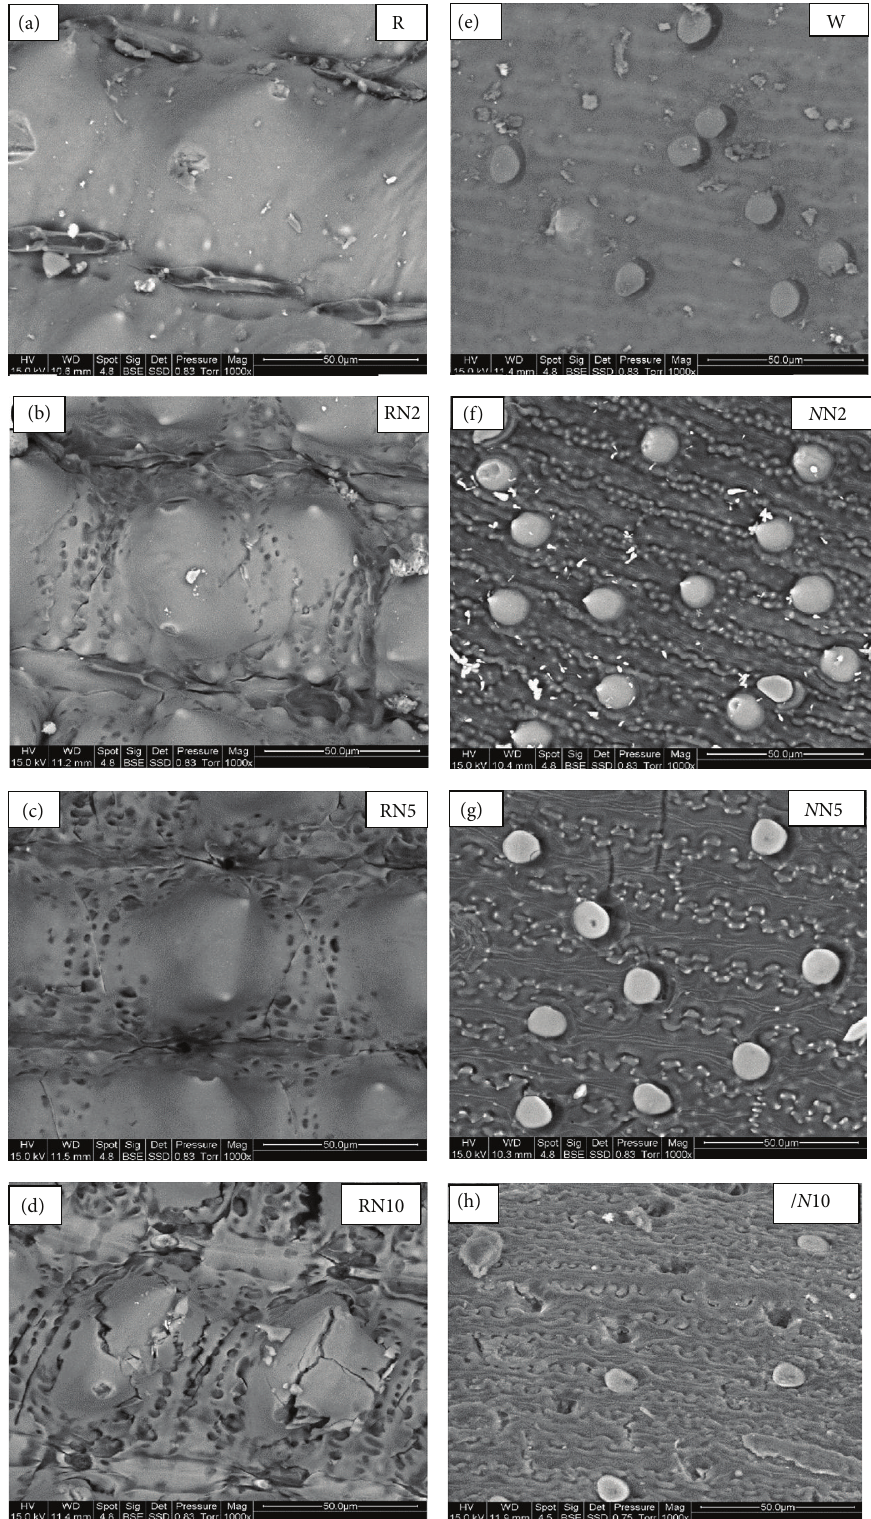
Figure 15: SEM micrographs of husks before and after treatment by NaOH: (a) untreated RH; (b–d) treated RH with NaOH concentration of 2%, 5%, and 10%, respectively; (e) untreated wheat husk; and (f–h) treated wheat husk with NaOH concentration of 2%, 5%, and 10%, respectively